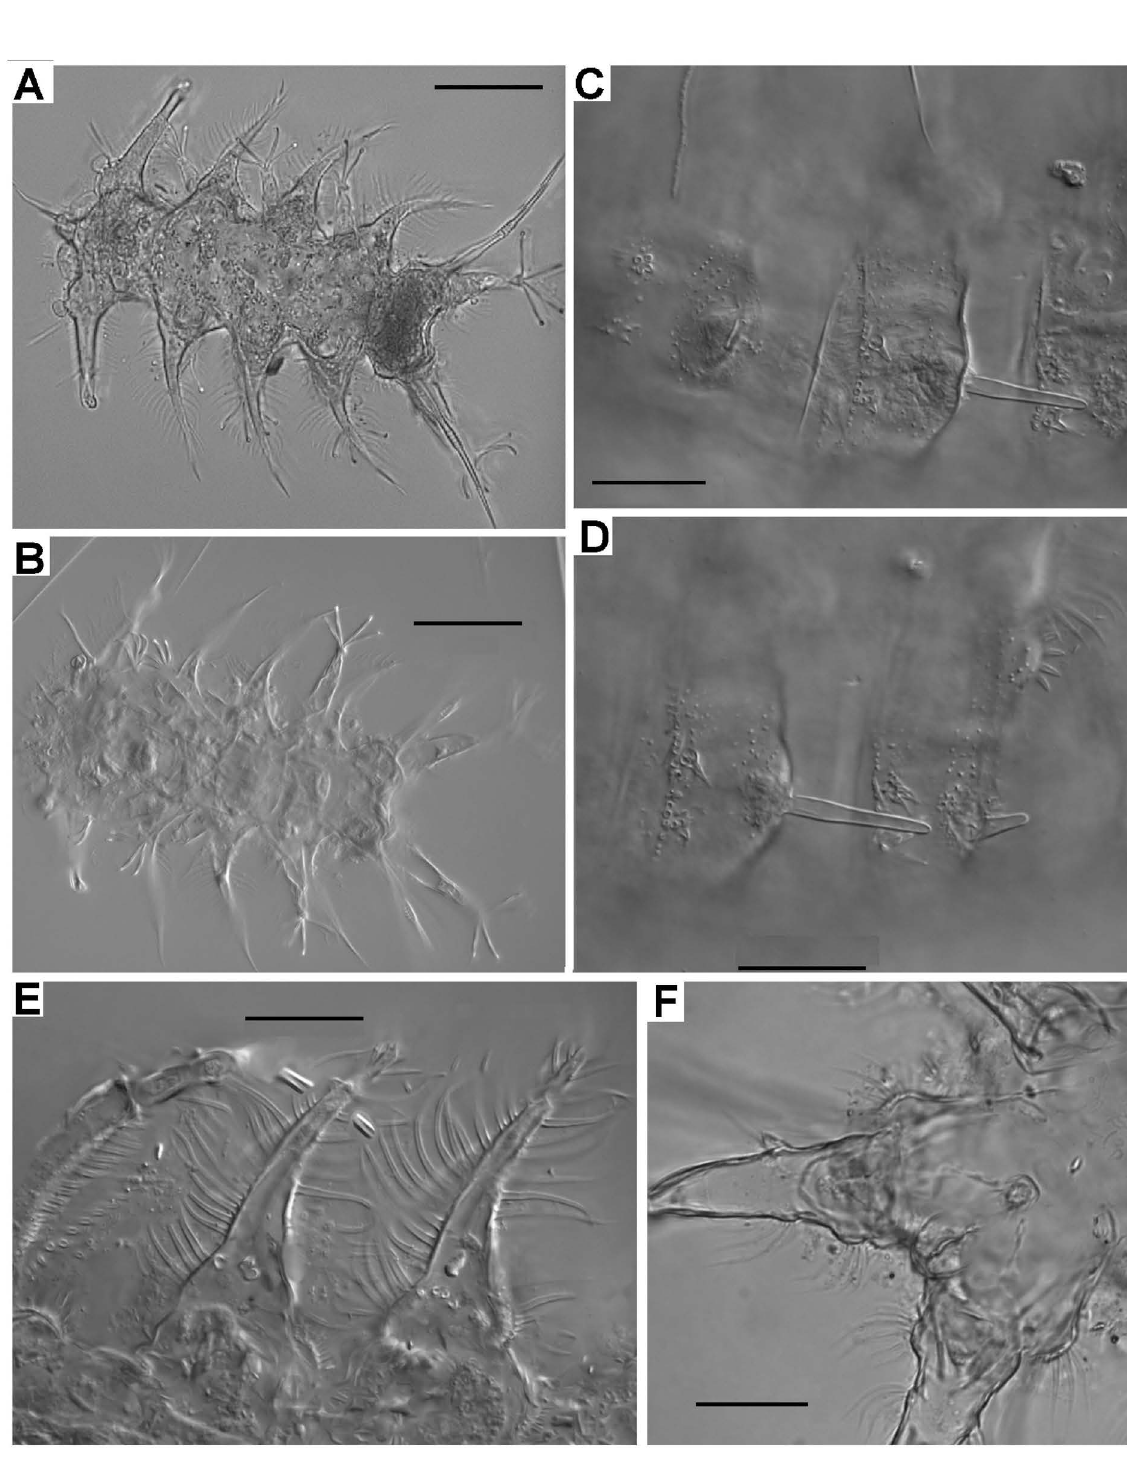
Fig. 4. Neostygarctus grossmeteori sp. nov., optical photopictures. A . Paratype, ♀ (SMF 54), entire body, dorsal view. B . Holotype, ♀ (SMF 51), entire body, ventral view. C–E . Paratype of obscure gender (SMF 59). C–D . Areas of dorsal surface of body with spines. E . Lateral body projections. F . Holotype, ♀ (SMF 51), posterior body with female gonopore and anus. Scale bars: A–B = 50 μm; C–F = 20